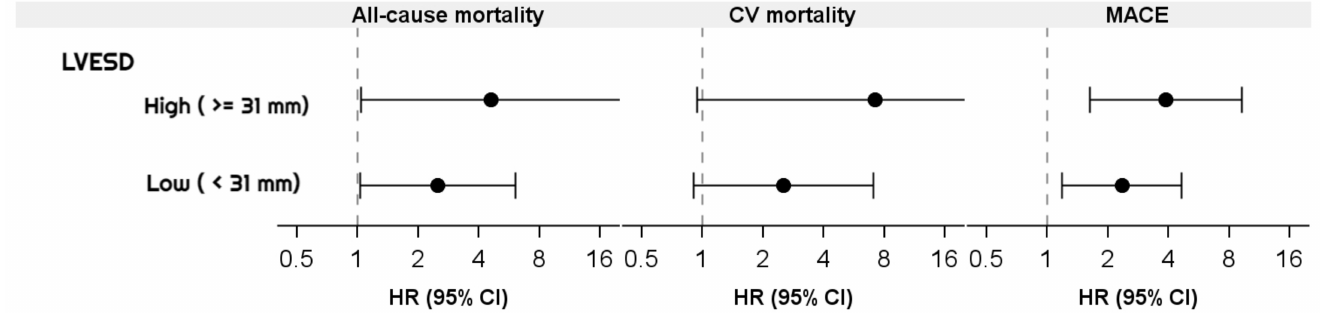
Figure 3. Forrest plot for all-cause mortality, CV mortality, and MACE among IVCD between high and low LVESD groups. CV, cardiovascular; MACE, major adverse cardiovascular events; IVCD, inferior vena cava diameter; LVESD, left ventricular end-systolic diameter; HR, hazard ratio; CI, confidence